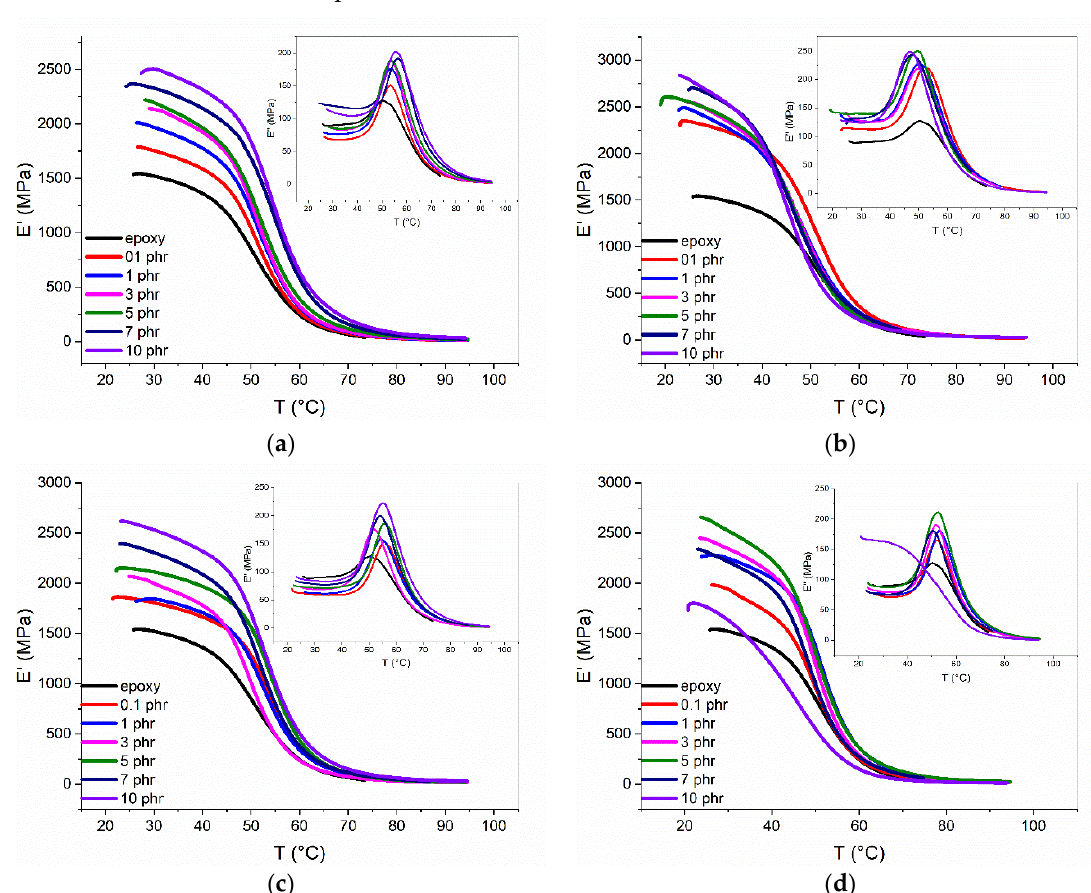
Figure 4. Comparative plots of the storage modulus as a function of temperature for the nanocomposites with ( a ) carbon black; ( b ) MWCNT; ( c ) GnP; ( d ) ND. Insets depict the respective loss modulus as a function of temperature.